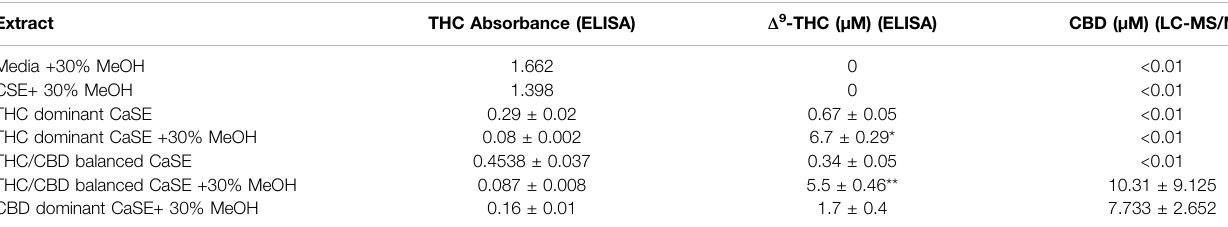
TABLE 2 | Estimated concentration of Δ 9 -THC and CBD in